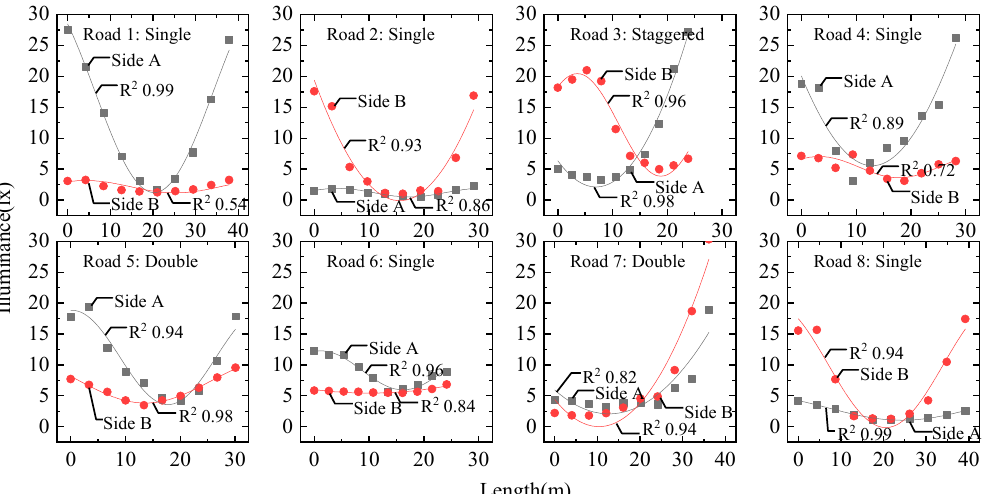
Figure 3. Illuminance distributions of two sides in the longitudinal direction of eight real road lighting scenes. These roads include the three road types: single, double, and staggered types.